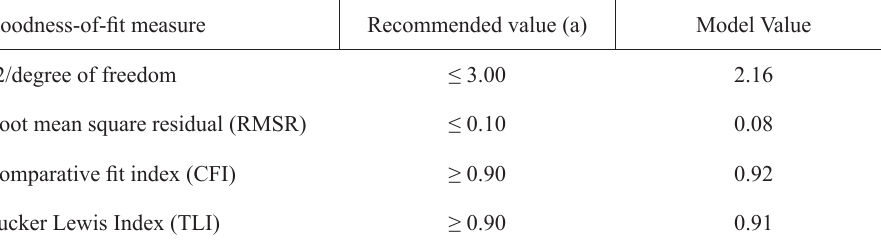
Table 7. Goodness-of-fit indices of study model